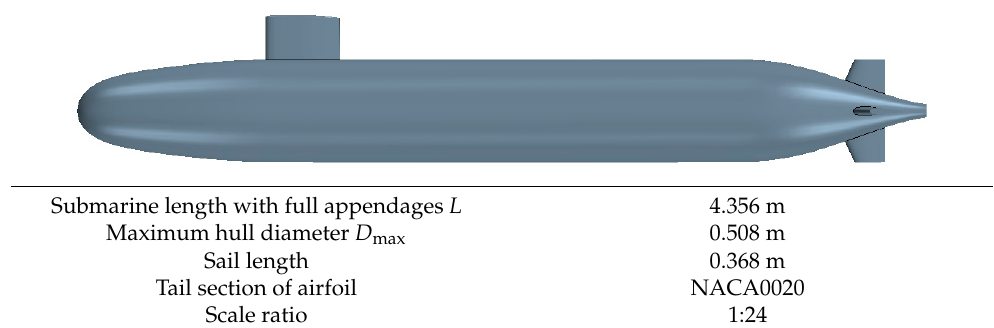
Table 1. Main parameters of SUBOFF.